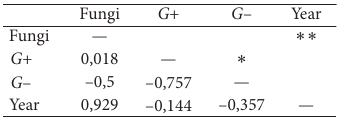
Figure 6: Statistical dependence between microorganism and year ( p < 0 . 05 � single star, p < 0 . 01 � double star symbol, p < 0 . 001 � triple star).